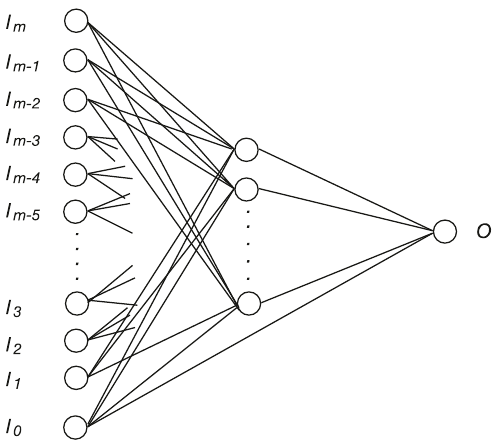
Fig. 1. Network with ( left ) input nodes and ( right ) the single output node. The input signal, f I k ; k (cid:136) 1 ; 2 ; ... ; m g , is propagated to the output, through the hidden nodes where the signal is transformed by nonlinear functions. The input I 0 is a bias that is set to 1.0 and connected to all hidden and output nodes in